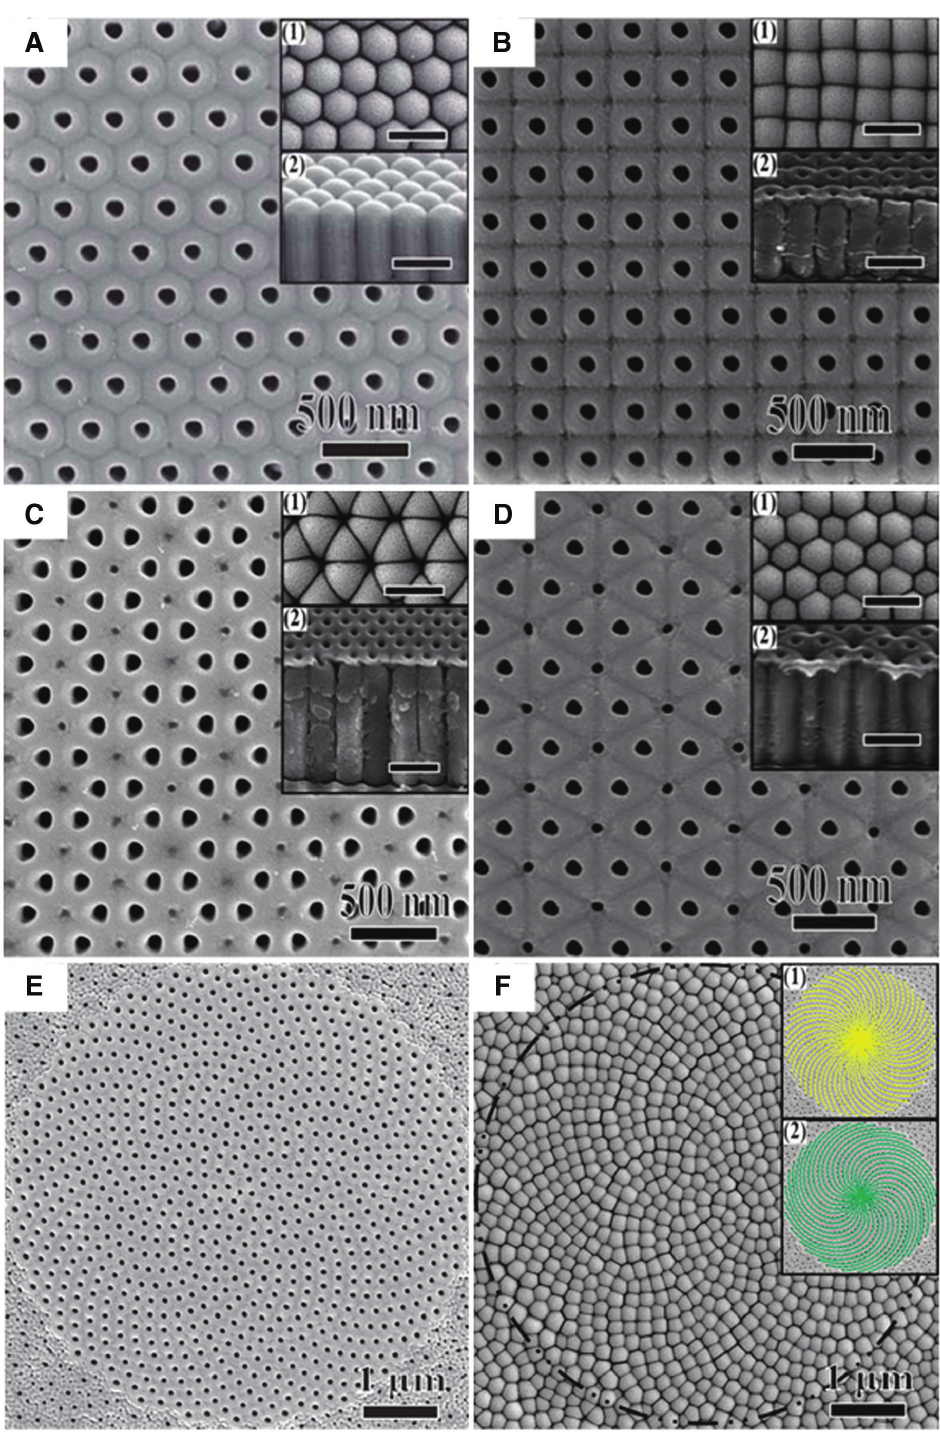
Figure 12 Various NT morphologies by FIB-guided anodization. (A, B) The hexagonal or square arrangement of closely packed NT arrays with excellent pore periodicity. Insets (1) and (2) are the bottom and cross-sectional SEM images, respectively. The scale bars are all 500 nm. (C) Triangular-shaped NTs guided by patterns arranged in a graphite lattice. The interpore distance is 225 nm and no new tubes form at the lattice center. (D) The hexagonal arrangement of alternating-sized NTs fabricated by patterned graphite lattice. As a result, the self-compensating effect, small-sized NTs grow at the centers of the lattice. (E, F) The top and bottom morphologies of TiO grown from FIB guiding patterns, respectively. Insets (1) and (2) in (F) show the counterclockwise and clockwise spirals in NT sunflowers, respectively. (A, B, D) Reprinted with permission from Ref. [260]. (C, E, F) Reprinted with permission from Ref. [263]. Copyright (2011) The Royal Society of